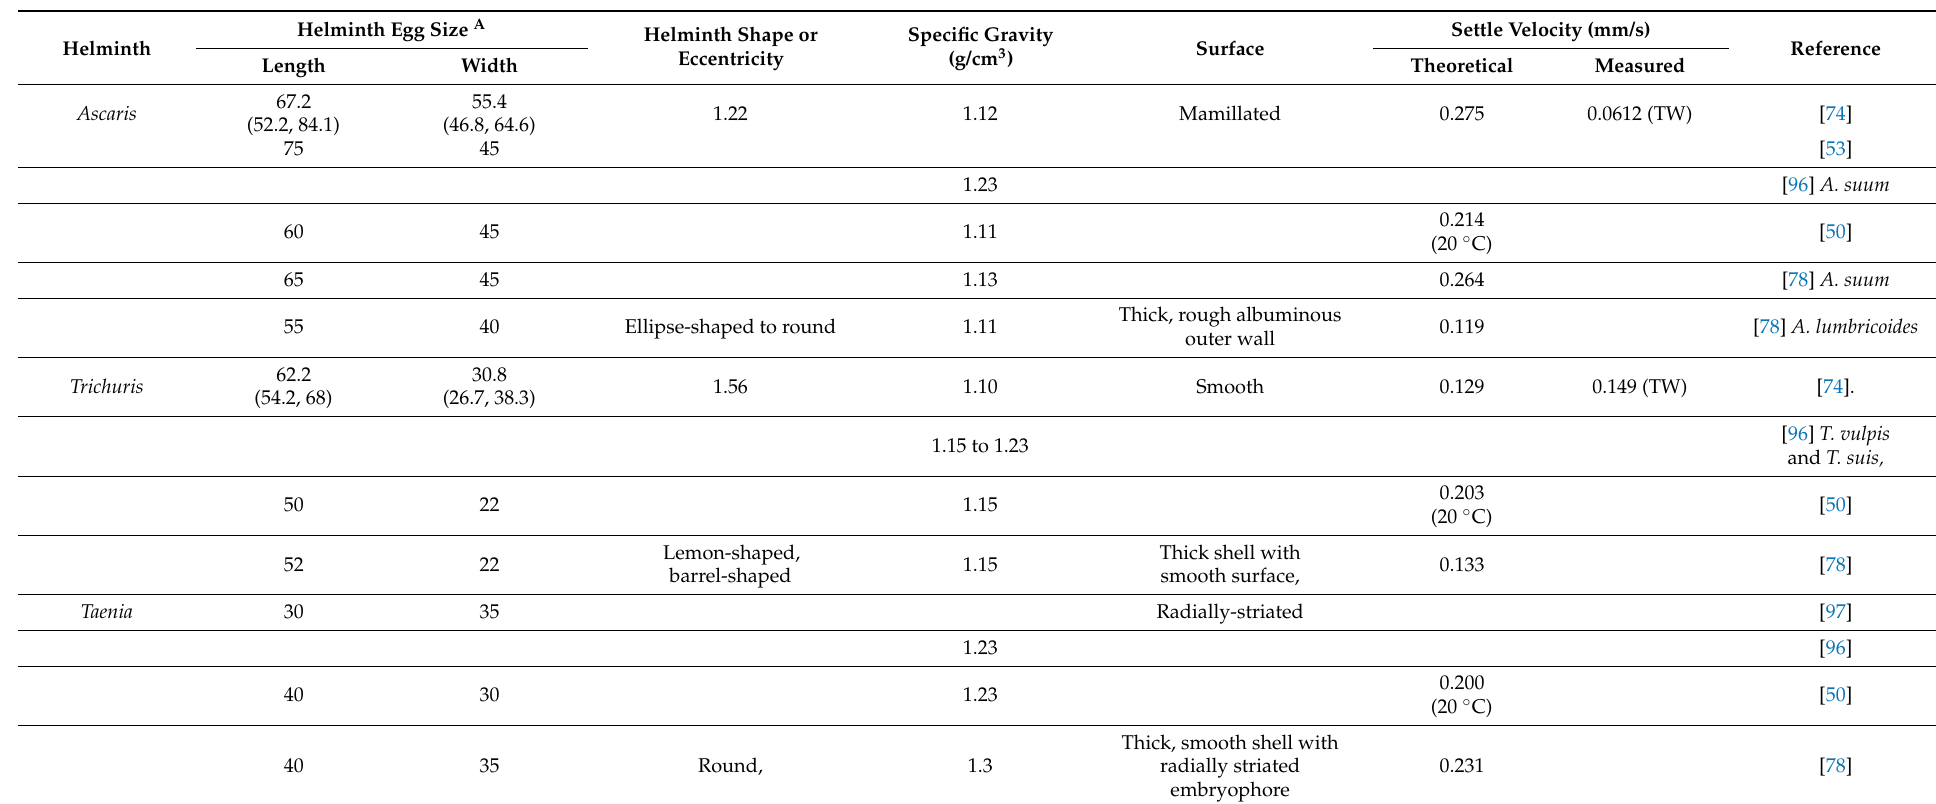
Table 5. Average helminth egg dimensions, specific gravity, surface theoretical and settling